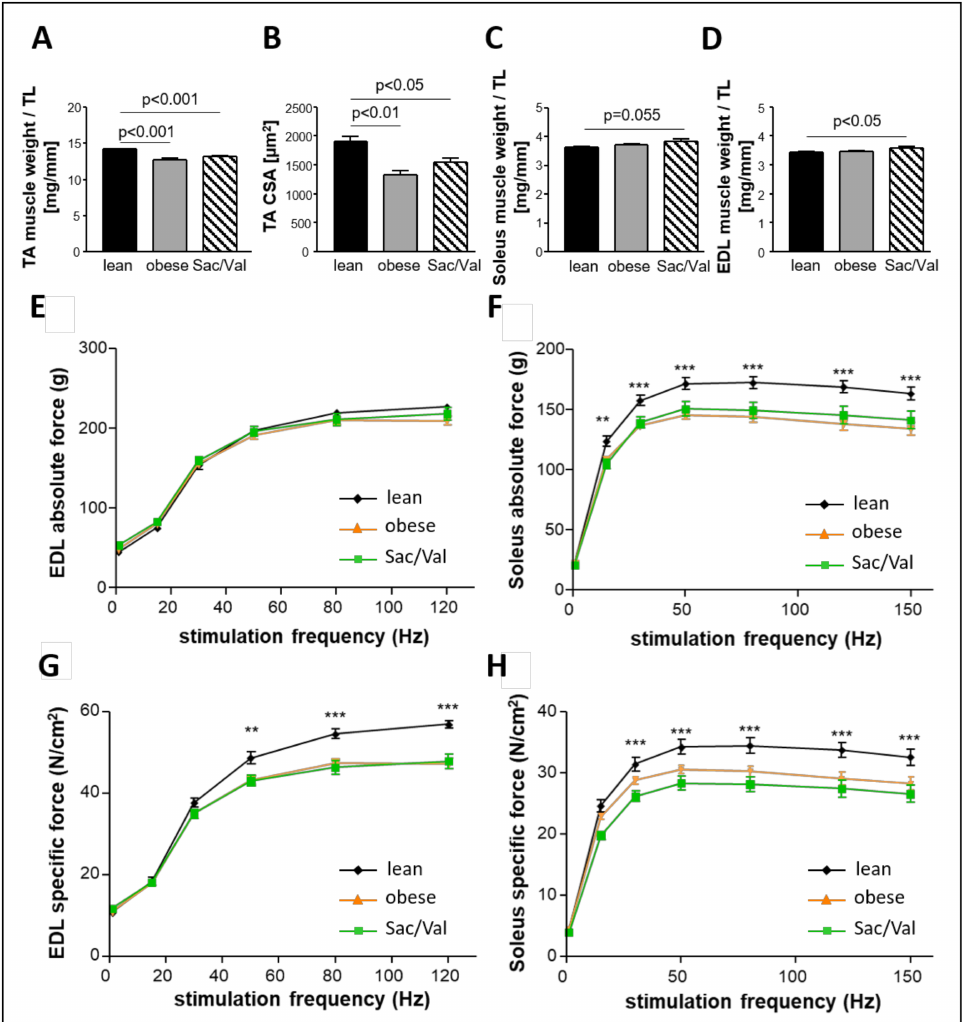
Figure 8. Skeletal muscle weight and function after 12 weeks of Sac/Val. Muscle weight (normalized to tibia length (TL)) ( A ) and cross-sectional area (CSA) of the TA muscle ( B ). Muscle weight of the Soleus ( C ) and the EDL ( D ), each normalized to tibia length. Absolute ( E , F ) and specific force ( G , H ) of the EDL ( E , G ) and Soleus ( F , H ). n = 13–15. To test the effect of Sac/Val, two-way ANOVA with repeated measures followed by Bonferroni post hoc was performed. ** p < 0.01, *** p < 0.001 vs. lean,